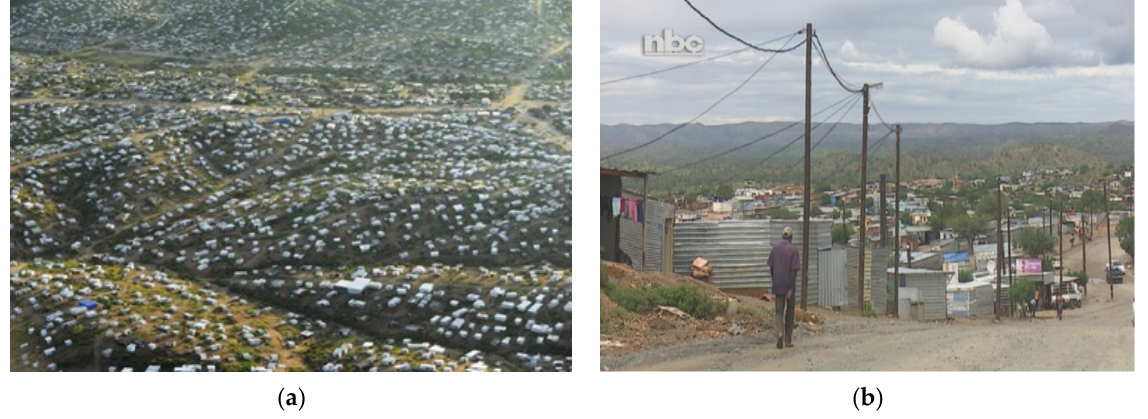
Figure 4. Different views of Havana informal settlement in Windhoek, Namibia: ( a ) An aerial view of the unstructured portion of the settlement [90]; ( b ) A closer view of the corrugated iron dwellings [91].